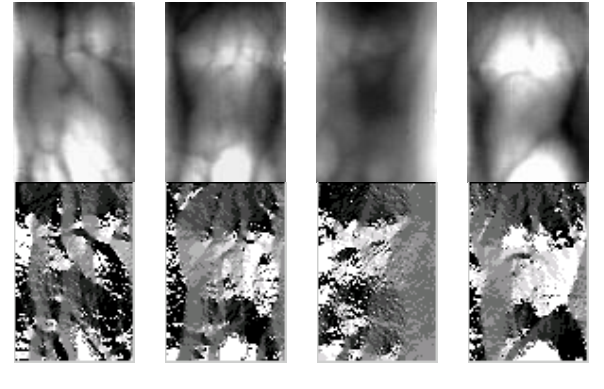
Figure 2. Finger vein images processed by LDC. The first row shows the original finger vein images, the second row shows the LDC images, respectively.